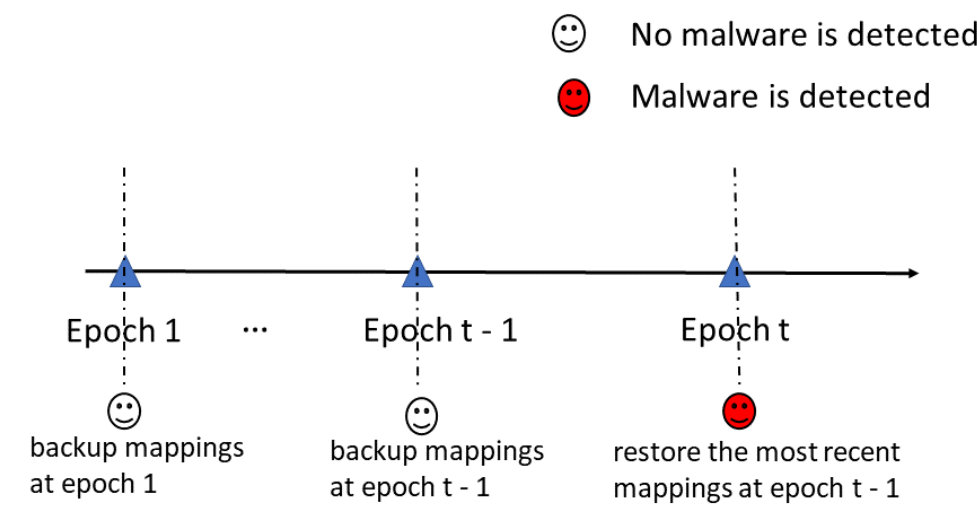
Figure 8. Mappings backup and